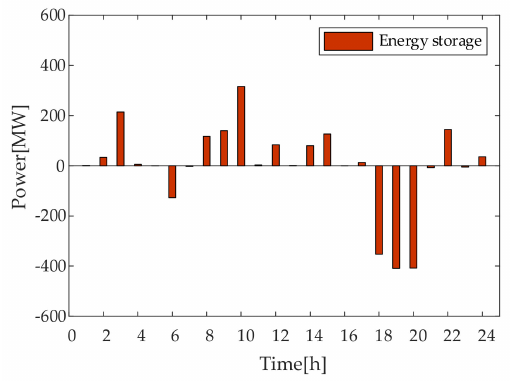
Figure 13. Result of interruptible loads optimal dispatch.